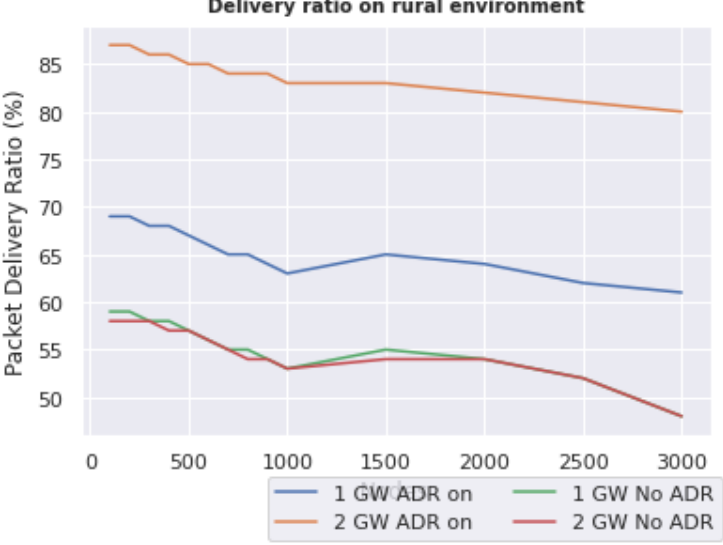
Figure 12. Packet delivery ratio measured with one and two gateways, with and without Adaptive Data Rate